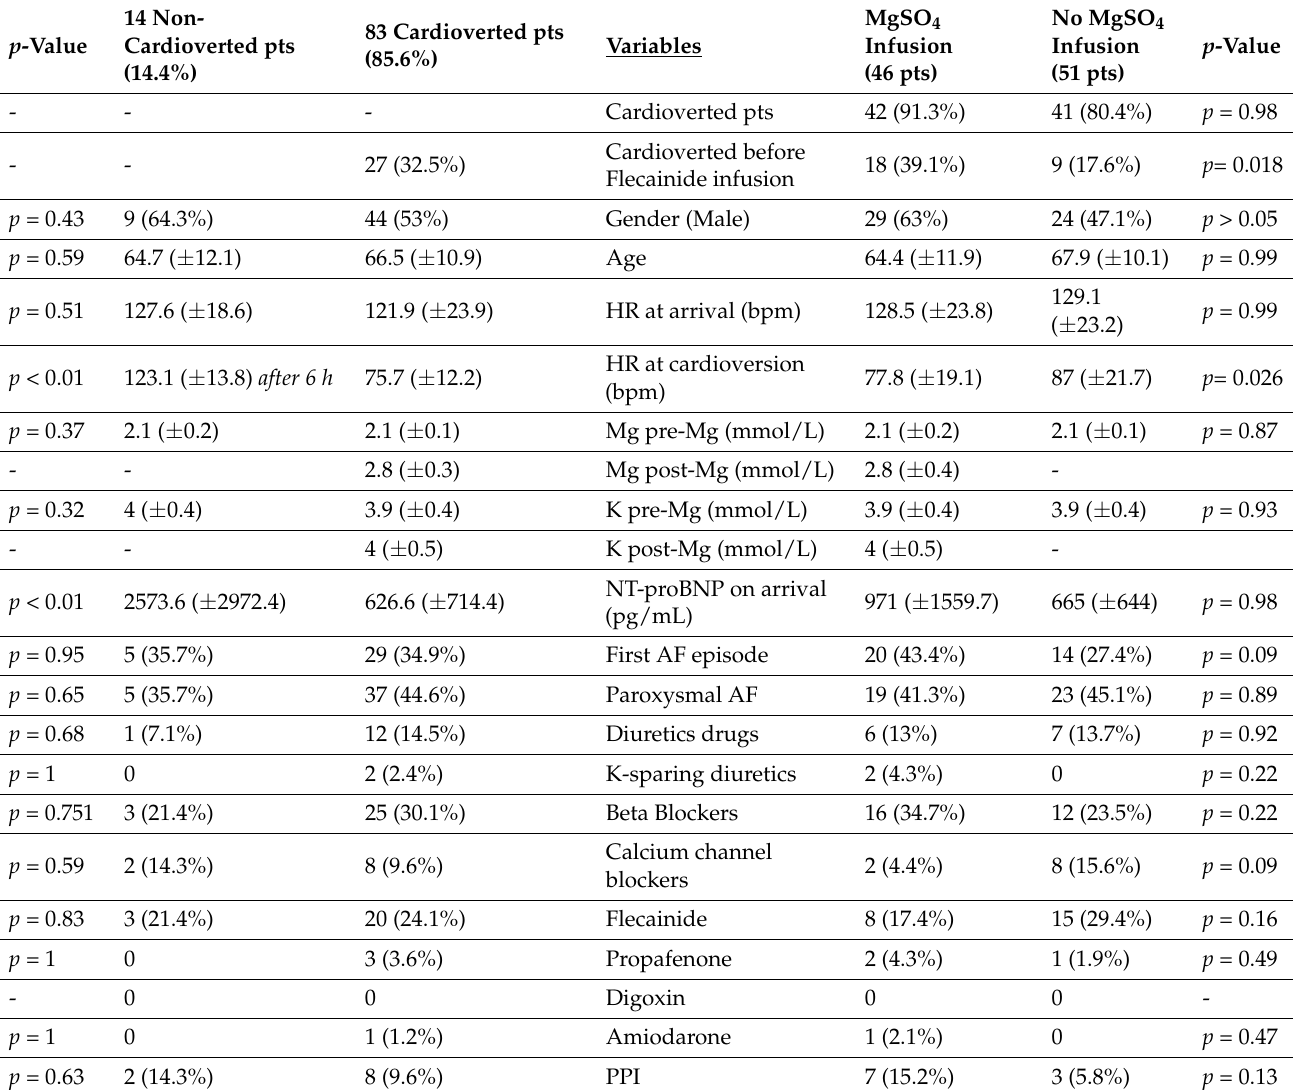
Table 1. Demographic Characteristics. On the LEFT, patients are classified in cardioverted